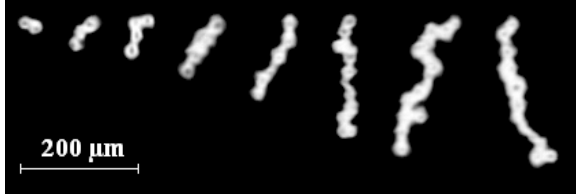
Fig. 10. Typical examples of chain-like aggregates ice crystals from 2 up to 15 individual frozen droplets.